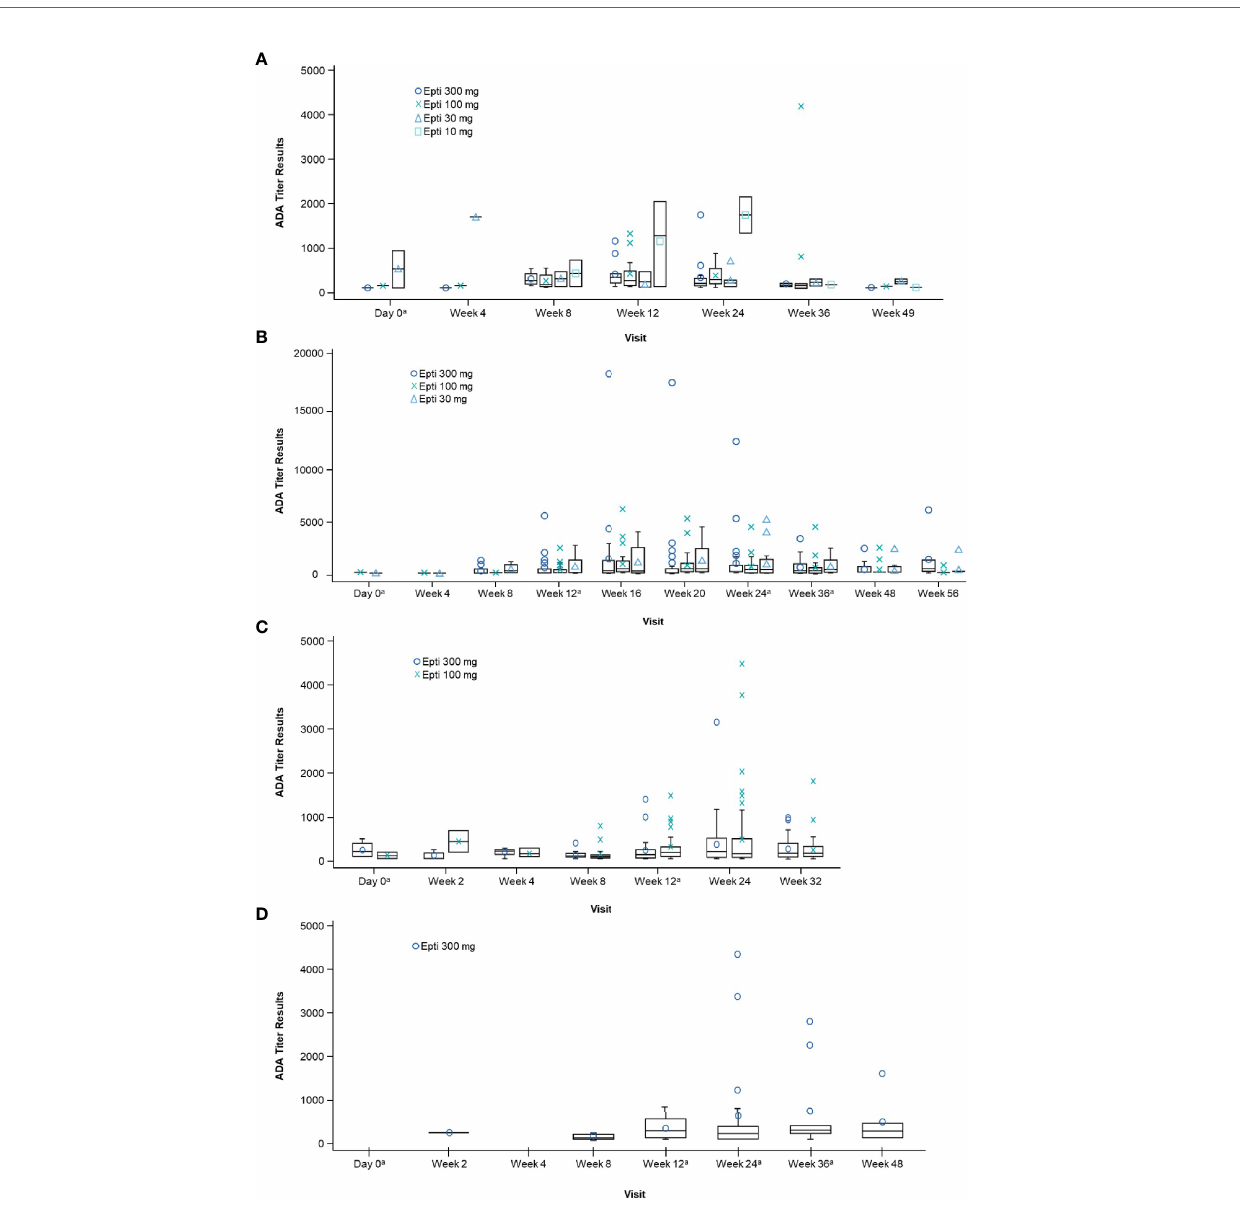
FIGURE 2 | Boxplot of positive ADA titer results by visit and treatment (safety population) in: (A) Study 2, (B) PROMISE-1, (C) PROMISE-2, and (D) PREVAIL. a On visits that coincided with treatment, ADA was measured pre-dosing. Note: Only patients with a con fi rmed ADA-positive status are summarized at each visit. ADA, anti-drug antibody; Epti, eptinezumab. ADA titer refers to the value obtained within screening assay through a series of dilutions beginning with the minimal required dilution of con fi rmed positive